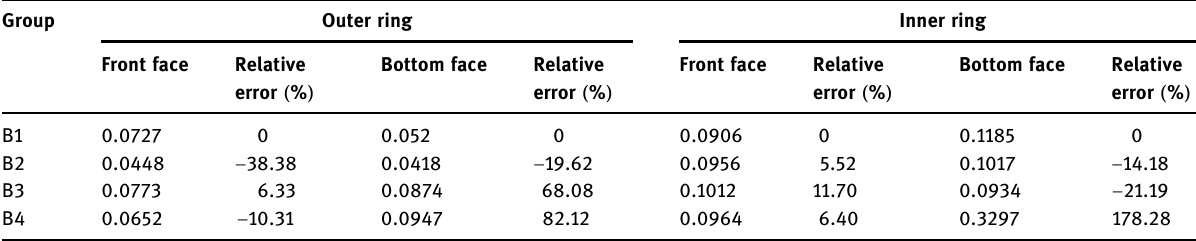
Group Outer ring Inner ring